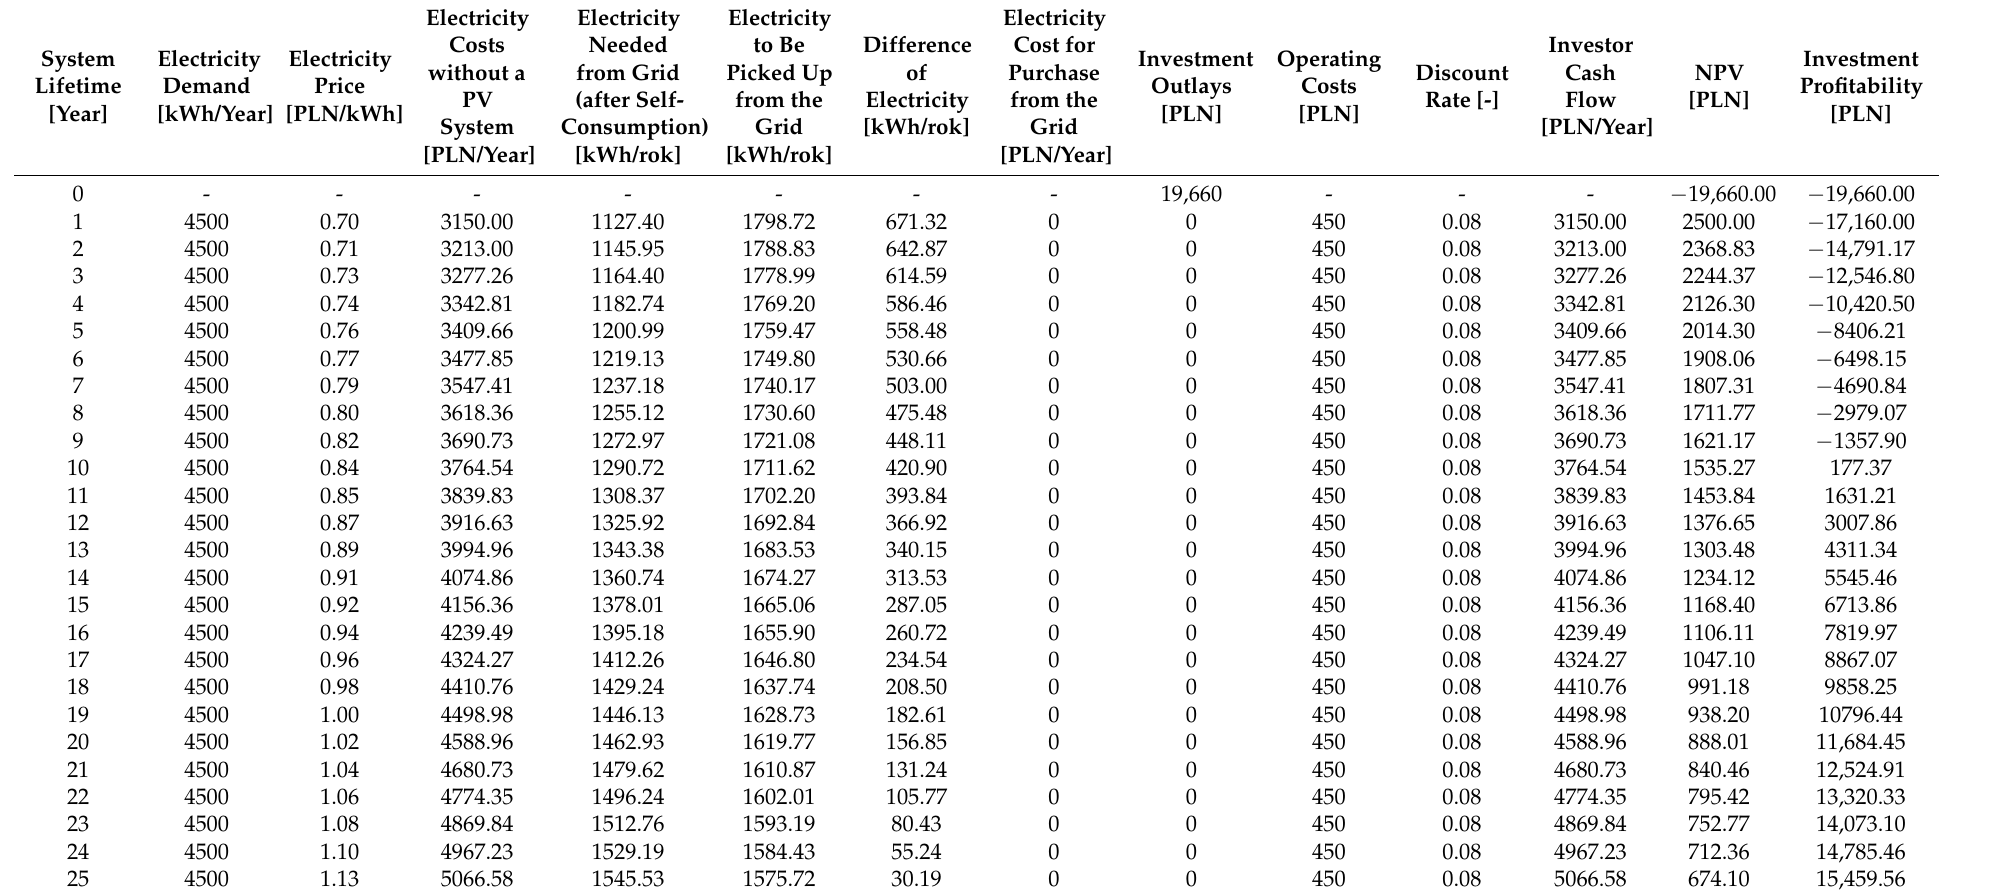
Table A8. NPV results of the PV installation for the discount system, at a 60% self-consumption